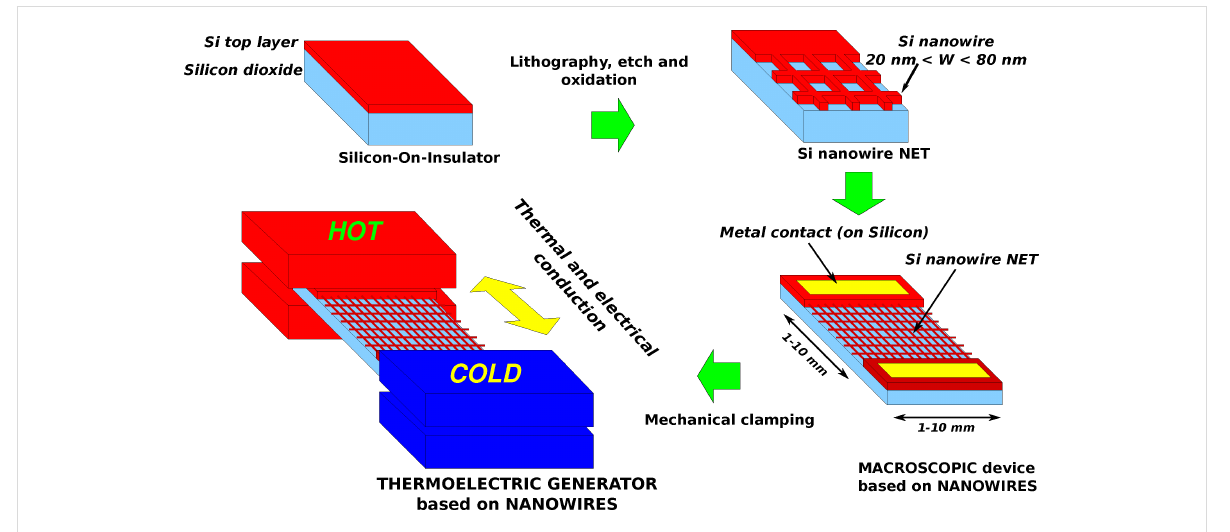
Figure 9: Sketches of the fabrication and mechanical clamping of a macroscopic thermoelectric generator based on nanowires.